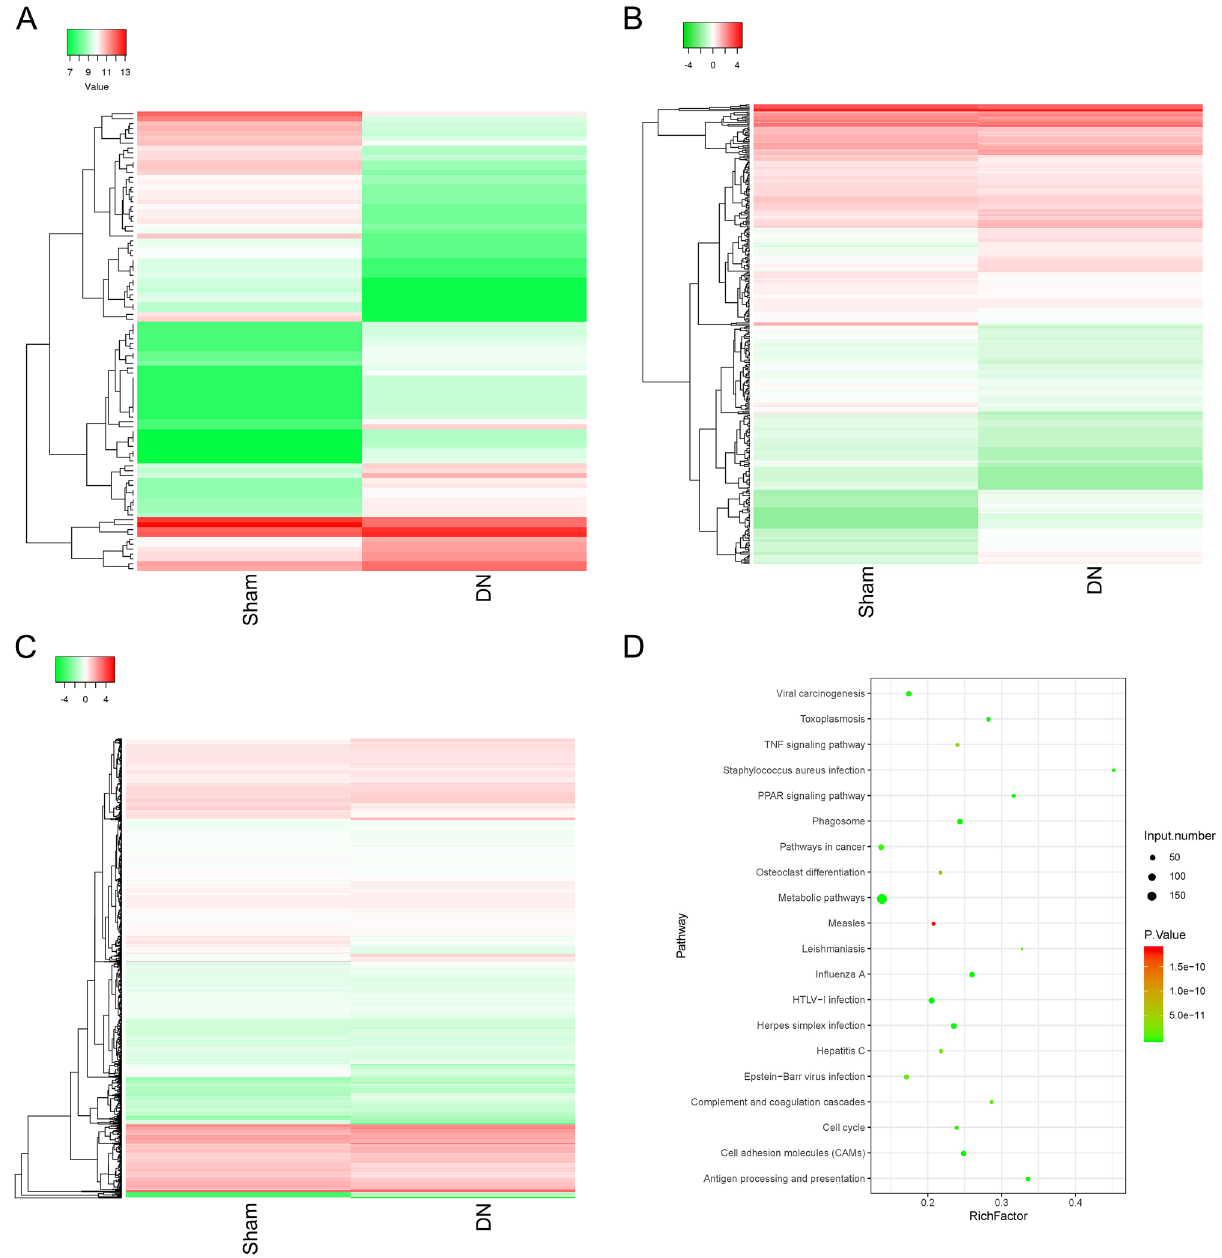
Figure 2. The bioinformatics analysis of differentially expressed circRNAs, miRNAs, and mRNAs between the DN and sham groups. ( A–C ) The clustering plot was used to show the differentially expressed circRNAs ( A ), miRNAs ( B ), and mRNAs ( C ). ( D ) Differentially expressed mRNAs were used for KEGG